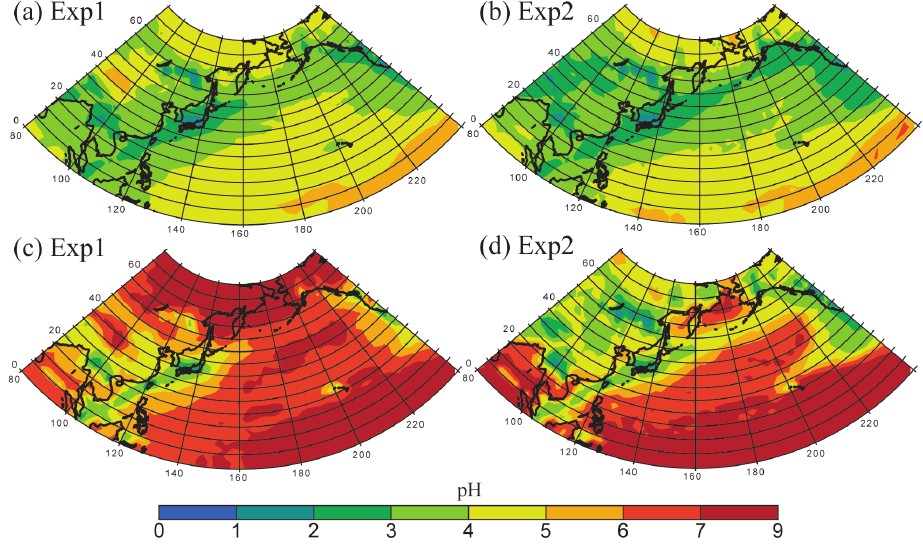
Fig. 5. Modeled pH in aerosols in the surface air during April 2001 for (a) the fine mode with the alkaline dust, (b) the fine mode without the alkaline dust, (c) the coarse mode with the alkaline dust, and (d) the coarse mode without the alkaline